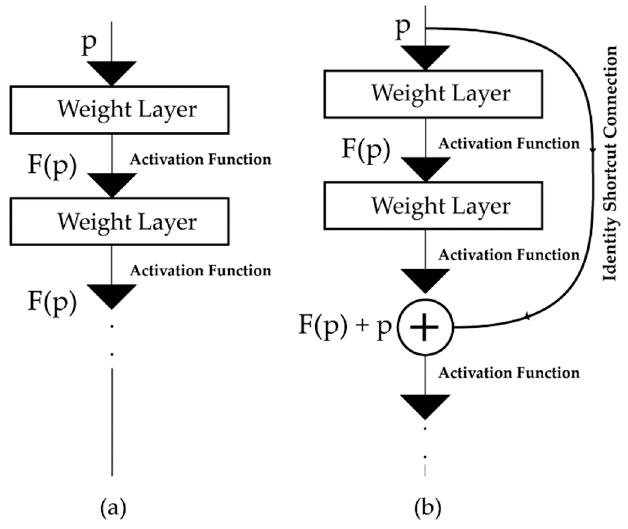
Figure 3. The connection mechanism of the feed-forward layers for neural architectures, i.e., ( a ) traditional neural networks, and ( b ) the residual neural network (ResNet)